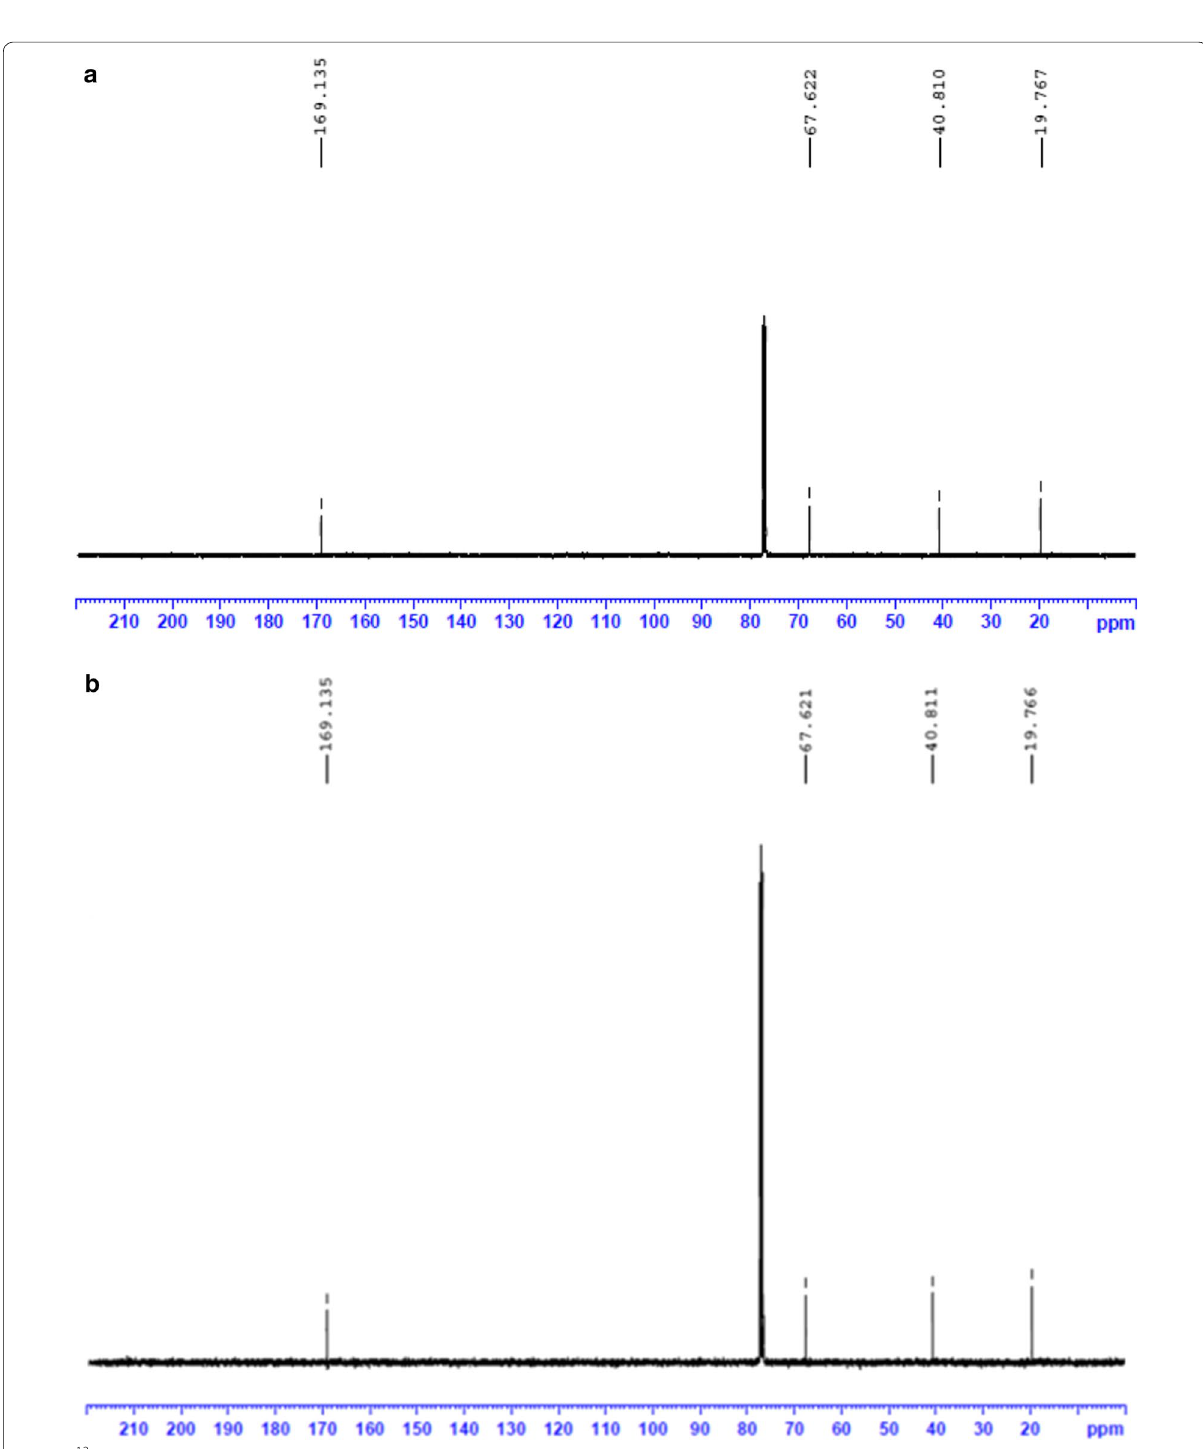
Fig. 5 13 C NMR spectra of the polymer suspended in CDCl 3 . a PHB standard (Sigma), b PHB from the recombinant